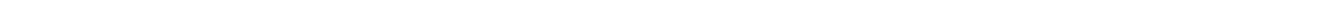
Fig. 7 Interactions of 16p11.2 homologs with neurodevelopmental genes. a Heatmap of change in phenotype measures (from manual scoring) in two-hit models of fl ies with knockdown of 16p11.2 homologs with core neurodevelopmental genes (left) or genes within CNV regions (right). Enhancers (orange) and suppressors (blue) for representative interactions of 16p11.2 homologs are shown. b Table summarizing the number of tested interactions of DOC2A rph , PPP4C pp4-19C , MAPK3 rl , and KCTD13 CG10465 with 50 neurodevelopmental and genes within other CNV regions. Of the 200 tested interactions measured by manual scoring or Flynotyper , 46 were identi fi ed as suppressors or enhancers of one-hit phenotype, and were validated in multiple RNAi or de fi ciency lines when available. c Representative bright fi eld adult eye images (scale bar = 50 µ m) and box plots of Flynotyper scores for simultaneous knockdowns of KCTD13 CG10465 , MAPK3 rl , PPP4C pp4-19C , and DOC2A rph with neurodevelopmental genes ( n = 5 – 13, * p < 0.05, Mann – Whitney test). d Representative confocal images of pupal eye (scale bar = 5 µ m) and larval eye discs (scale bar = 30 µ m) of the MAPK3 rl / PTEN dpten two-hit knockdown fl ies, stained with anti-Dlg and anti-pH3 respectively. e Box plot of photoreceptor cell count in the pupal eye of MAPK3 rl and PTEN dpten one-hit and two-hit fl ies ( n = 58-65, * p = 3.62 × 10 – 15 compared to one-hit knockdown of MAPK3 rl , Mann – Whitney test). f Box plot of pH3-positive cells in the larval eye between MAPK3 rl and PTEN dpten one-hit and two-hit fl ies ( n = 9, * p = 0.00174 compared to one-hit knockdown of MAPK3 rl , Mann-Whitney test). All boxplots indicate median (center line), 25th and 75th percentiles (bounds of box), and minimum and maximum